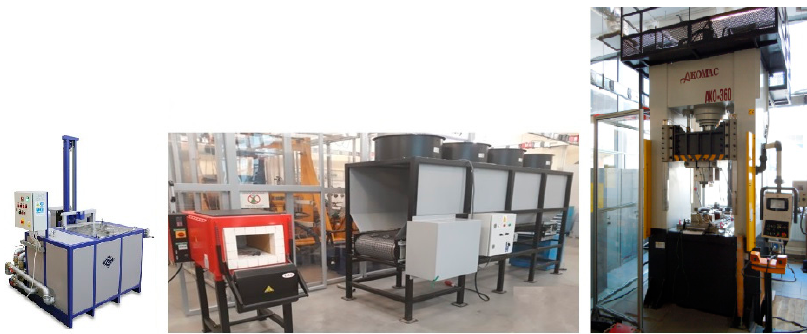
Figure 8. Exemplary arrangement of the test stand for thermoplastic treatment.